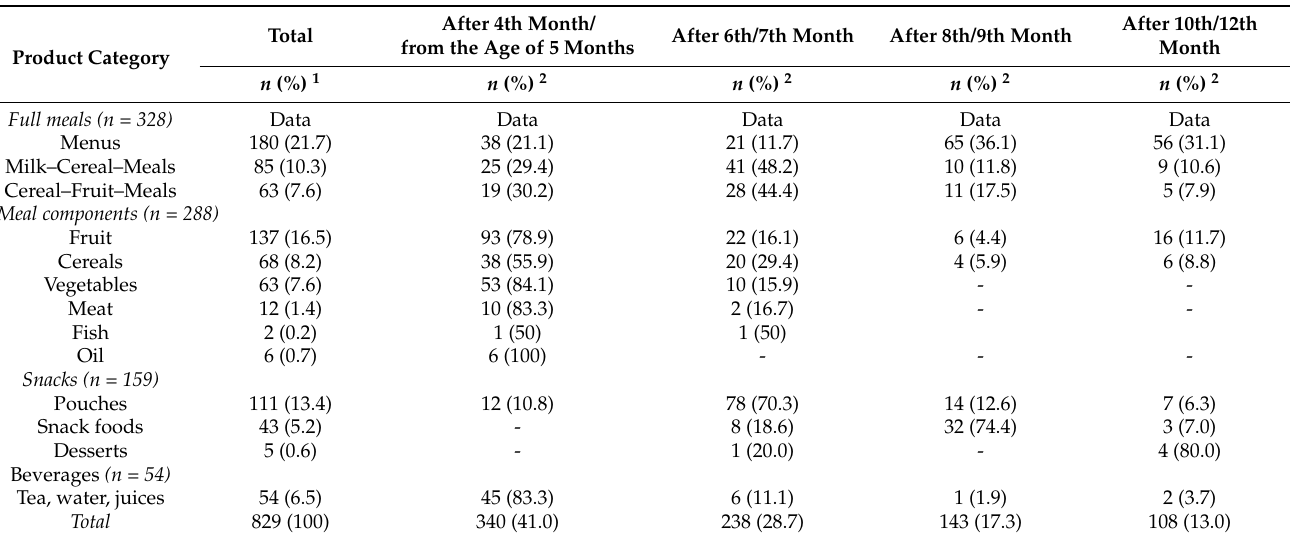
Table 1. Product categories and declared age of infants’ commercial complementary foods, results